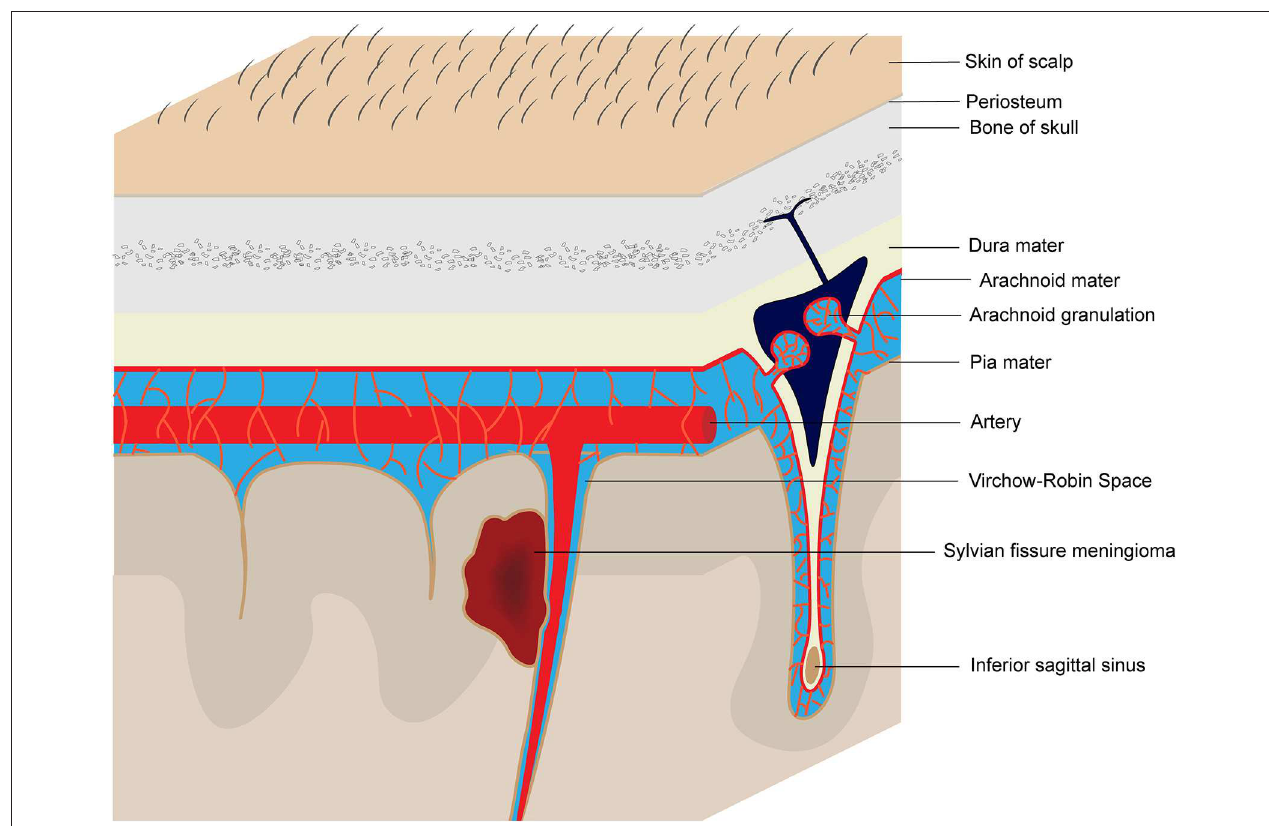
FIGURE 3 | Schematic diagram of the origin of Sylvian fissure meningiomas.